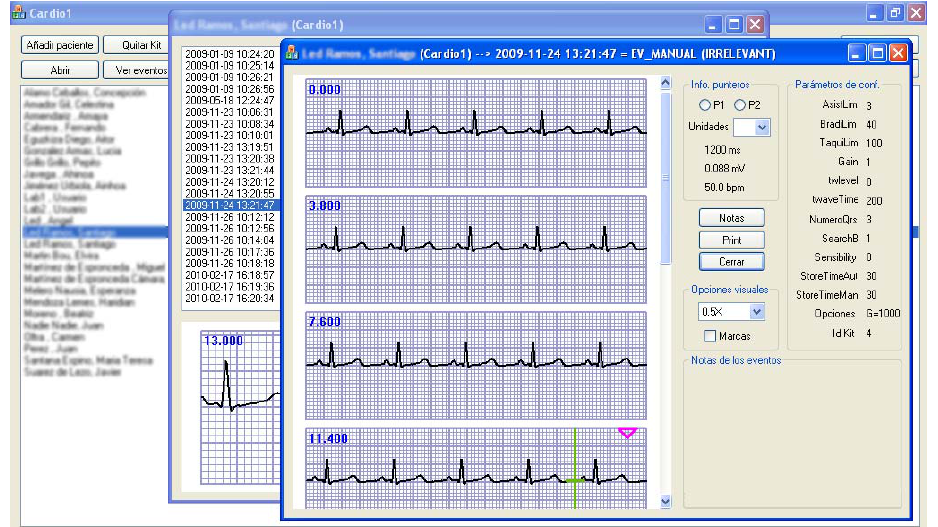
Figure 13. Real ECG waveform transmitted by the HOLTIN in the indoor